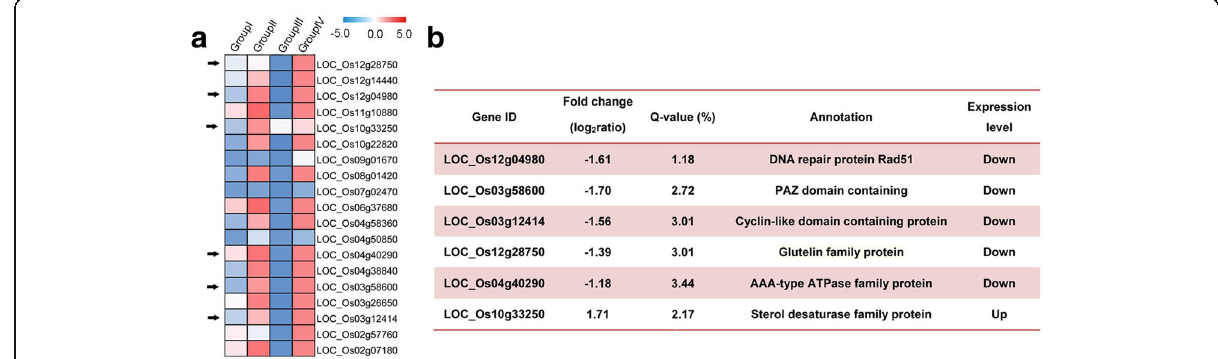
Fig. 7 Expression patterns of DEG associated with meiosis process in Group III. a Expression patterns of putative meiosis stage and meiosis specific genes. Genes indicated by arrows are meiosis related genes, while other genes are meiosis stage specific. b Annotation and expression levels of primary DEG related to meiosis identified from Group